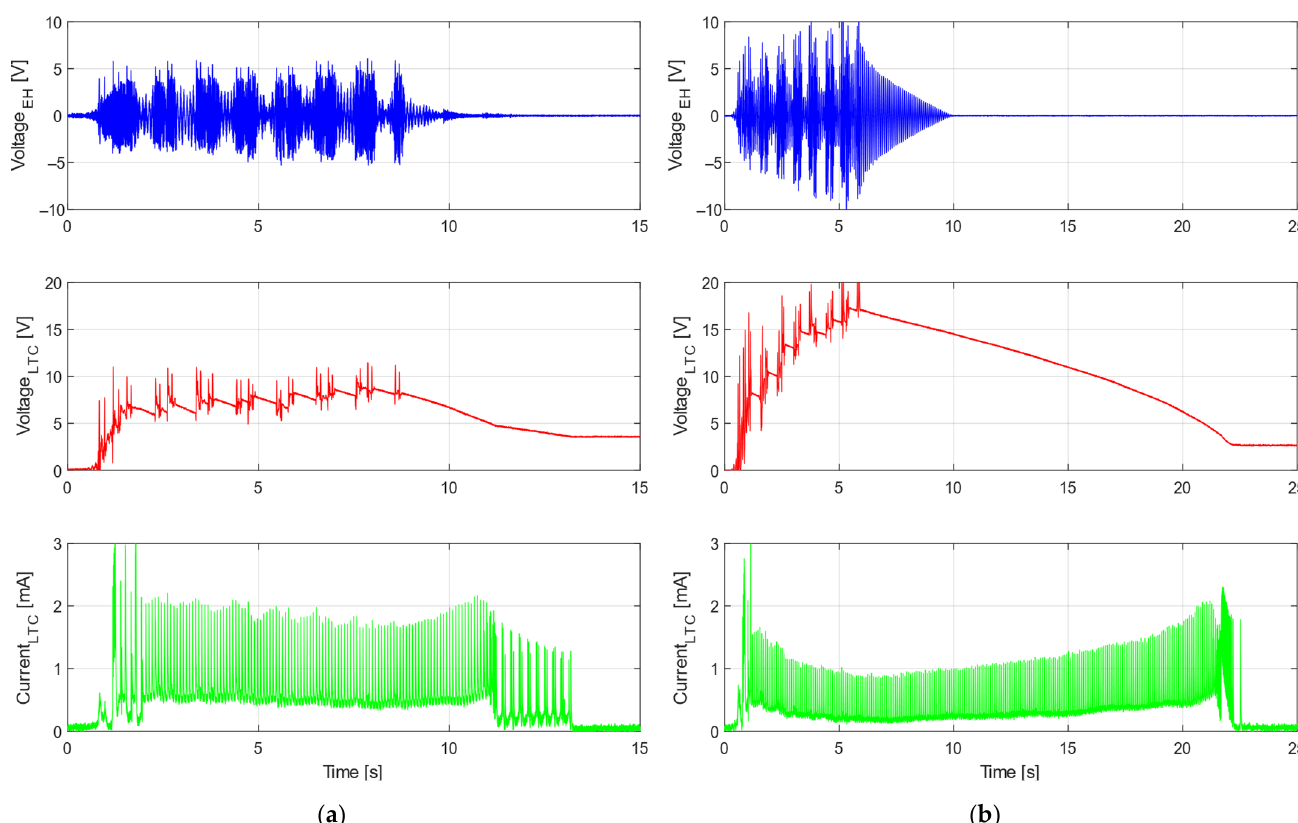
Figure 14. Shaker test with real acceleration data from Train 1 ( a ) and Train 2 ( b ) with connected power electronics; measured voltage and current according to electric schema. Video